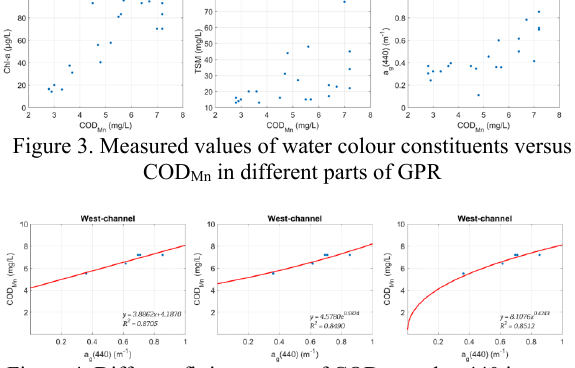
Figure 4. Different fitting curves of COD Mn and ag440 in west- channel of GPR